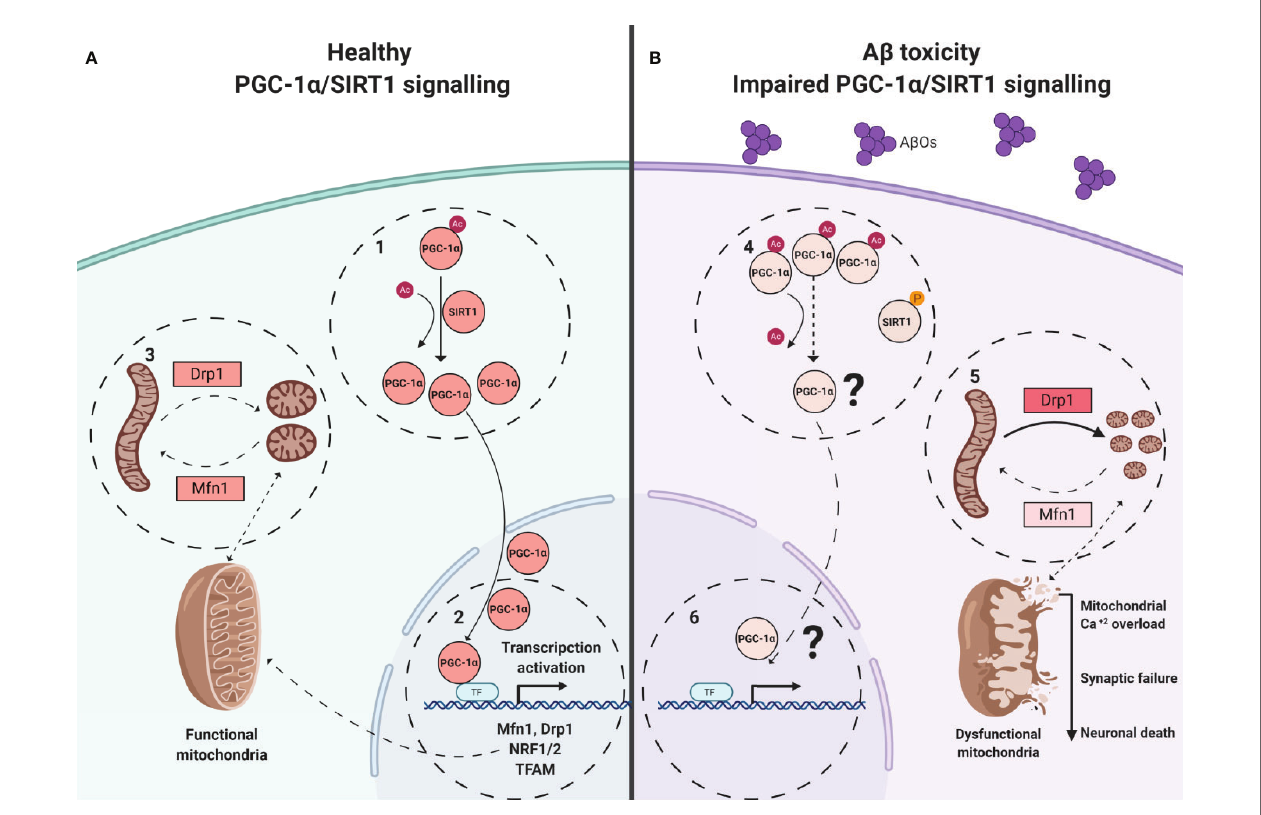
FIGURE 12 | Model of alterations induced on SIRT1/PGC-1 a pathway by A b Os. (A) . Healthy neuronal conditions were energy depletion and/or decreased catabolic rates can be sensed by SIRT1 promoting the PGC-1 a deacetylation (1). Transcription and co-activates of factors like NRF- 1/2 for the expression of nuclear- encoded mitochondrial genes and dynamic mitochondrial proteins, requires of PGC-1 a translocation (2). Coordinated mitochondrial dynamics (3, fi ssion/fusion), depends of adequate expression of Mfn1, Drp1. (B) . In A b Os treated neurons, the PGC-1 a is unable to be deacetylated and to translocate to the nucleus (4). The expression of key genes is loss (5), and imbalance between fusion and fi ssion to promote the granular mitochondrial phenotype (6) and neuronal